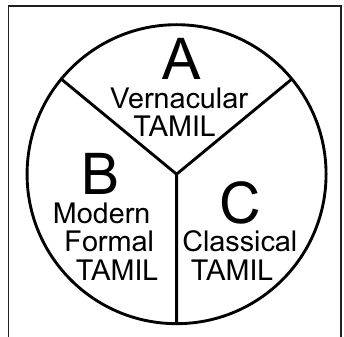
Figure 3: Three languages called ‘Tamil’ (the Tamil triglossia).